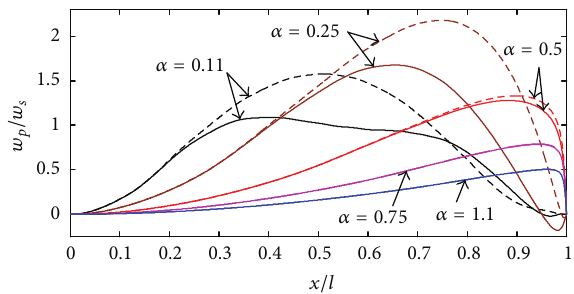
Figure 6: Variation of dimensionless instantaneous dynamic lateral deflection, 𝑤 𝑝 /𝑤 𝑠 , versus normalized instantaneous position of moving mass, 𝑥/𝑙 , of the Timoshenko beam traveled at different speeds with 𝑚 = 3𝜌𝐴𝑙 kg, 𝑘 1 = 10 4 N/m 2 , 𝑐 = 10 3 N ⋅ s/m 2 , and 𝛽 = 0.3 ; (- - - - -) M-1 model, (—) M-2, or M-3 model with = 10 21 N/m 4 . 𝑘 3